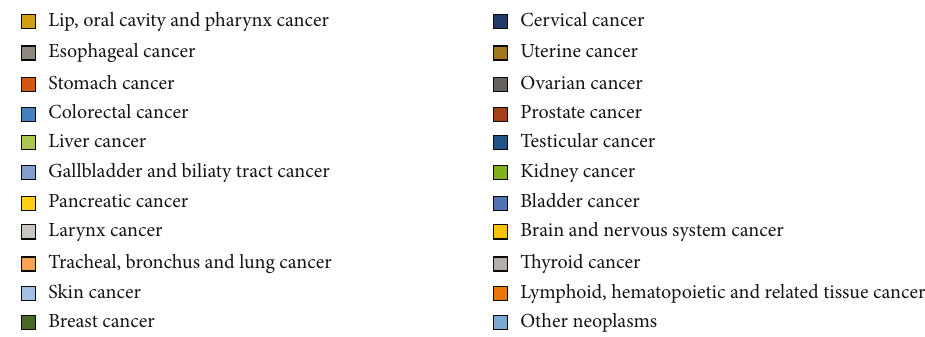
Figure 5: Age-speci fi c contributions of cancer types to total cancer incidence for both sexes, 2016. For International Classi fi cation of Disease codes pertaining to each neoplasm group, see eTbale 1 in the